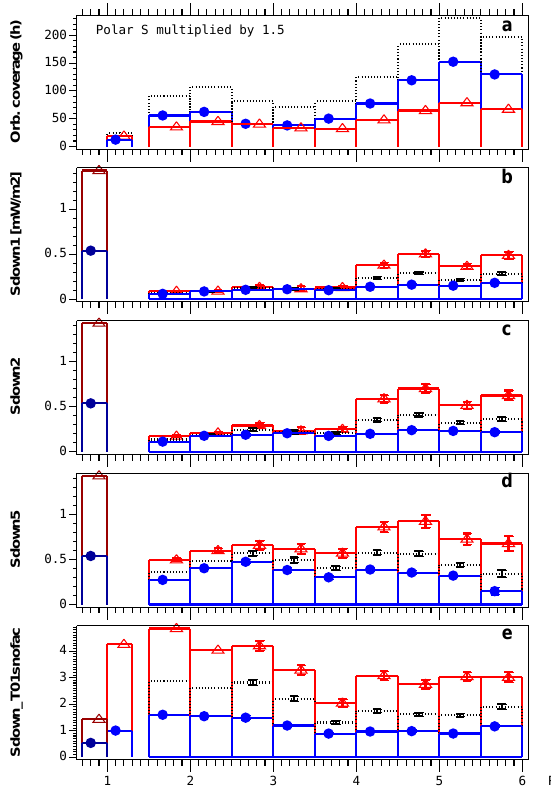
Fig. 3. Distribution of DC Poynting vector against distance for three background magnetic field models. Panels from top to bottom: or- bital coverage (a) , IGRF backgrond (b) , T01s NOFAC background (the one used in other figures) (c) and T01s background (d) . Other- wise format similar to Fig.